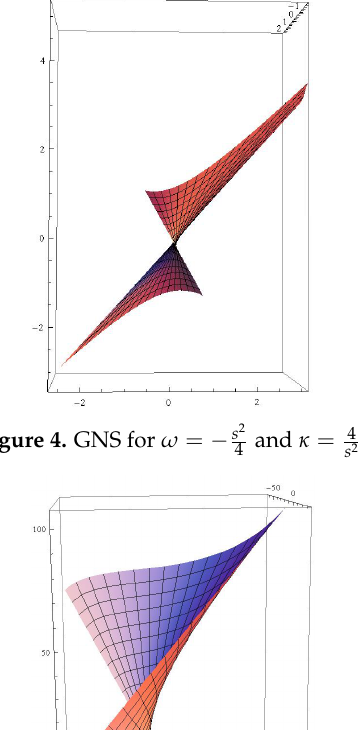
Figure 5. GNS for ω = 2 s 2 and κ = − 1